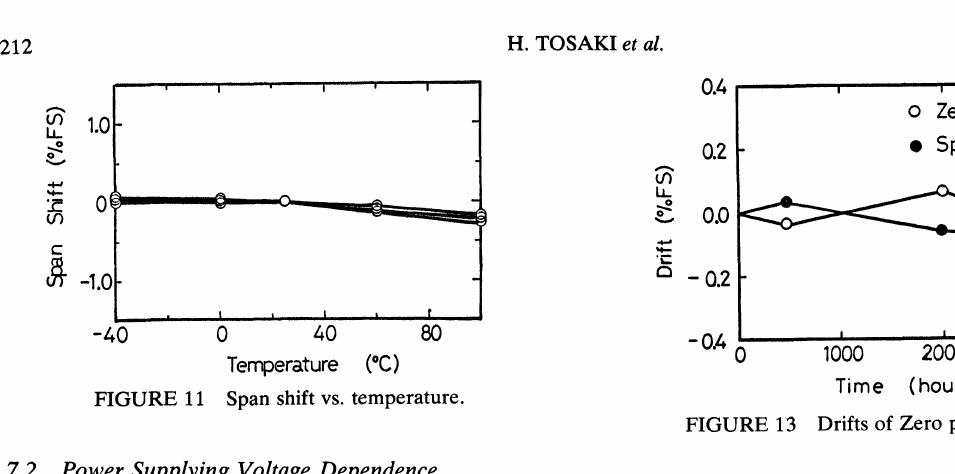
FIGURE 13 Drifts of Zero point and Span.